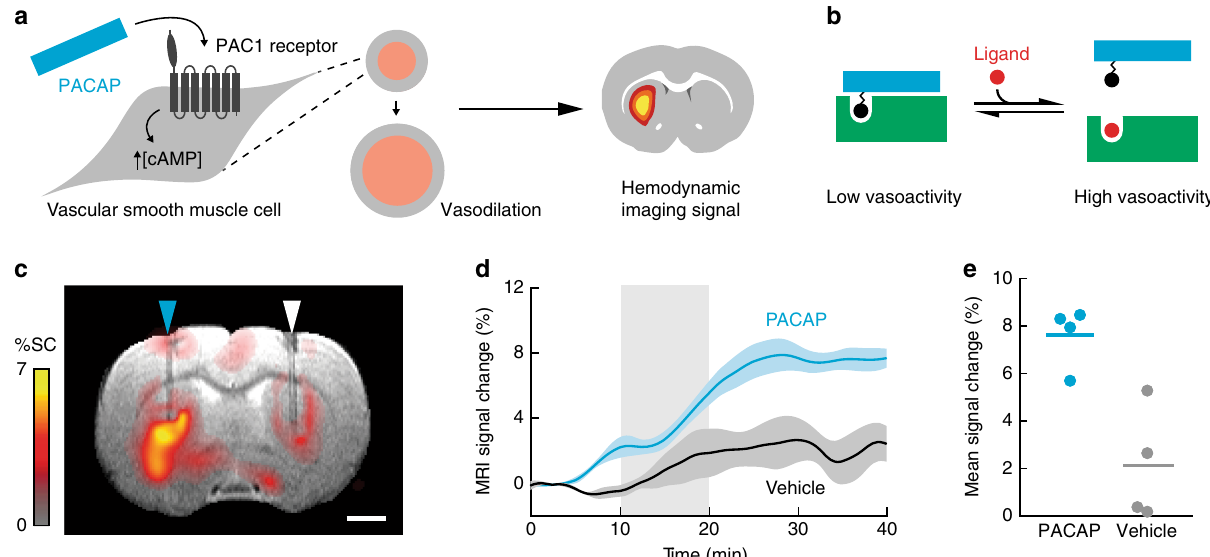
Fig. 1 Platform for AVATar construction. a PACAP (blue) functions as a vasoprobe by binding to receptors on vascular smooth muscle cells and activating a cAMP-dependent signaling cascade, causing blood vessel dilation and a hemodynamic imaging signal. b AVATar architecture: a tethered version of the target molecule is attached to PACAP peptide (blue); binding of a blocking domain (green) to the tethered target prevents receptor activation. Elevated free target molecule concentrations free active PACAP from the blocking interaction. c Map of mean MRI signal change following intracranial delivery of 1 µ M PACAP (blue arrowhead) compared to aCSF vehicle (white arrowhead), overlaid on an anatomical scan. Scale bar = 2 mm. d Mean MRI time courses during delivery of 1 µ M PACAP (blue) or aCSF vehicle (black). Shading represents SEM ( n = 4). e Average MRI signal change 30 – 40 min after PACAP or vehicle injection (horizontal lines = mean values, n =